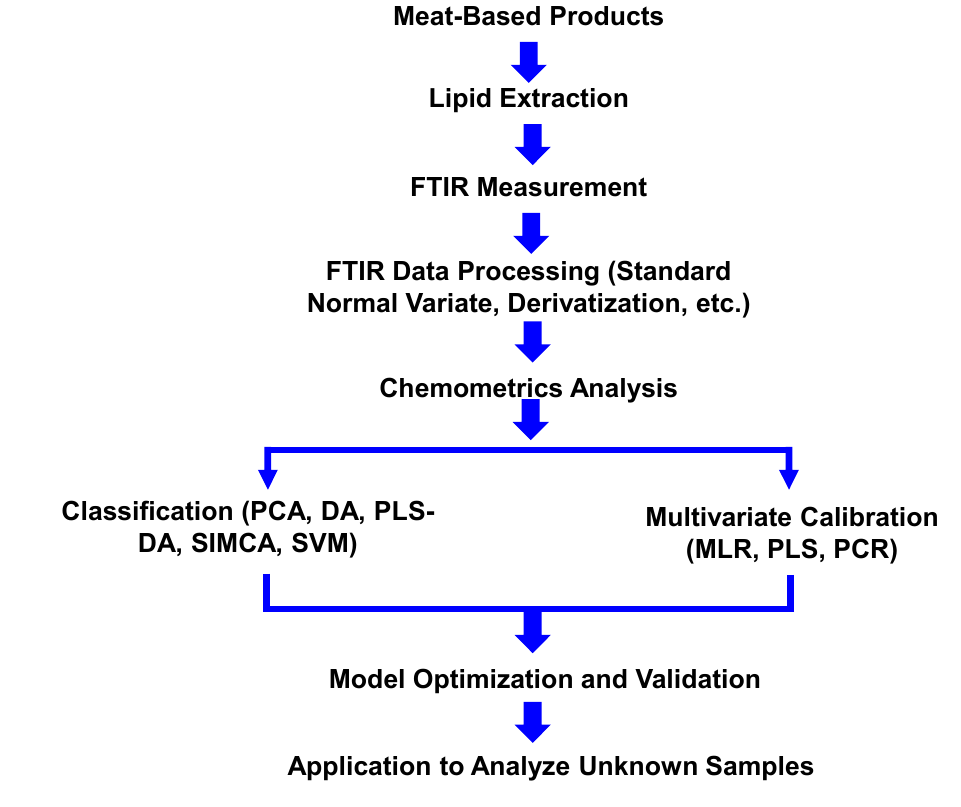
Figure 1. The analytical procedure for analysis of meat-based food products using FTIR spectroscopy method.